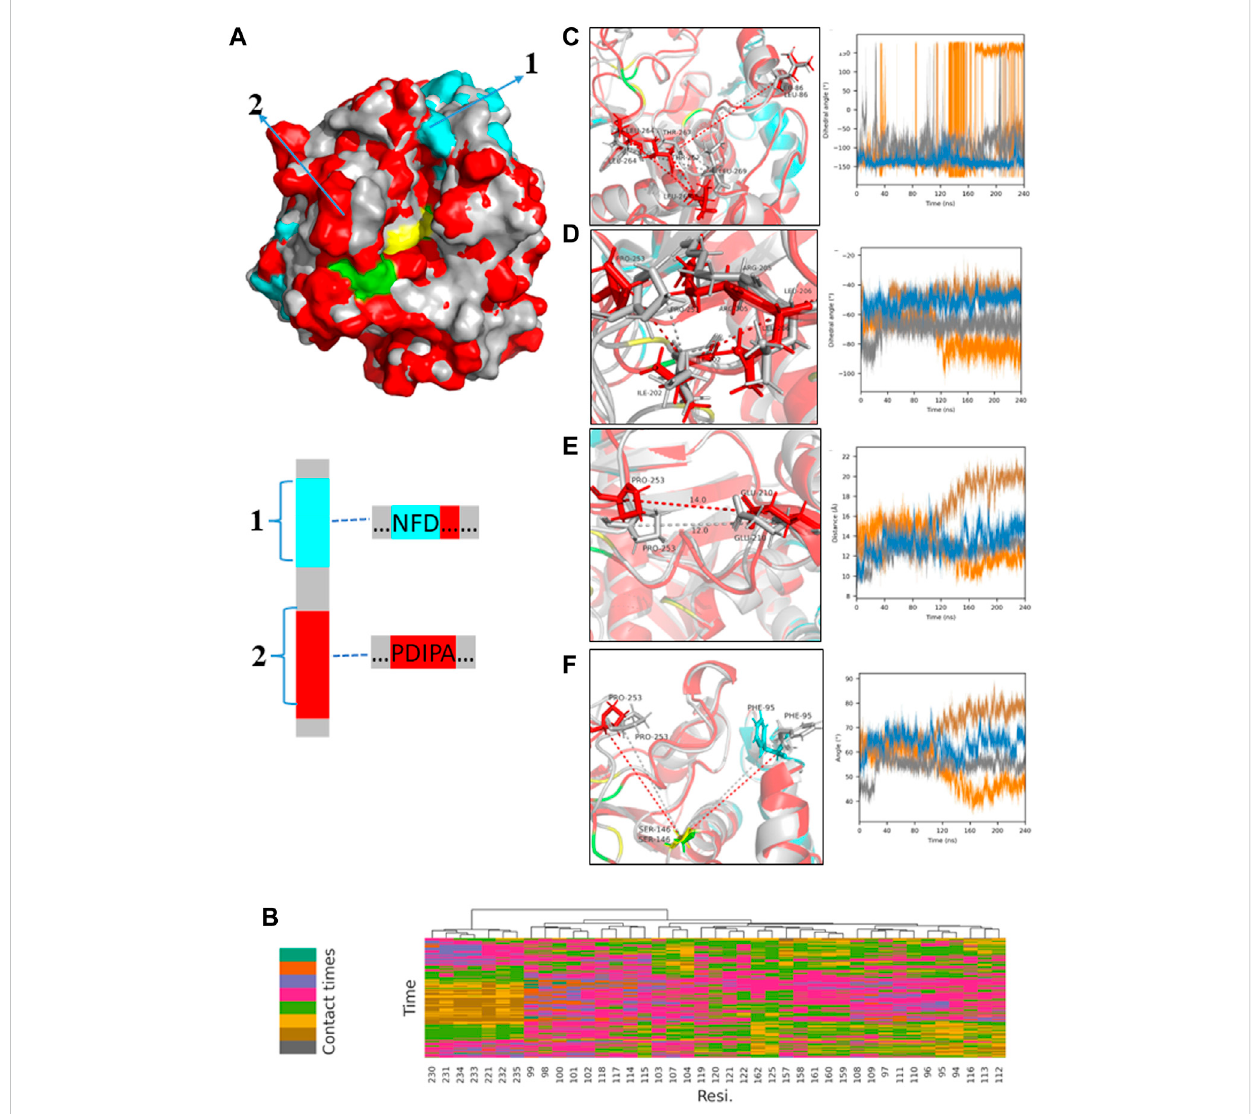
FIGURE 13 MD results for the micro-water system; (A) Comparison of the two protein molecular conformations of the original PLA1 (gray) and the PLA1 in the process of diffusion (red and cyan); the marked regions (1,2; amino acid sequences have been given) show the signi fi cant differences between the two PLA1 conformations and the cyan regions represent the better af fi nities with PC and DHA-TAG according to the results of (B) ; (B) Statistics of average interaction frequencies of each residue with substrate molecule DHA-TAG and PC; The cutoff value was used to highlight the residues which have strongeraf fi nitieswithsubstrates,whichweresetas70.Ifthetotalinteractionfrequencyofaresiduewithsubstrateduringthewholesimulationtimewas less than the cutoff value, this residue was hidden for the easier visualization. The interaction distance was set as 8 Å due to a larger steric hindrance; (C) Time evolution of the dihedral angle among L264, L269, T267, and L86 and its visualization result; (D) Time evolution of the dihedral angle among P253, I202, L206, and R205 and its visualization result; (E) Time evolution of the distance between P253 and E210 and its visualization result; (F) Time evolution of the angle among P253, S146 and F95 and its visualization